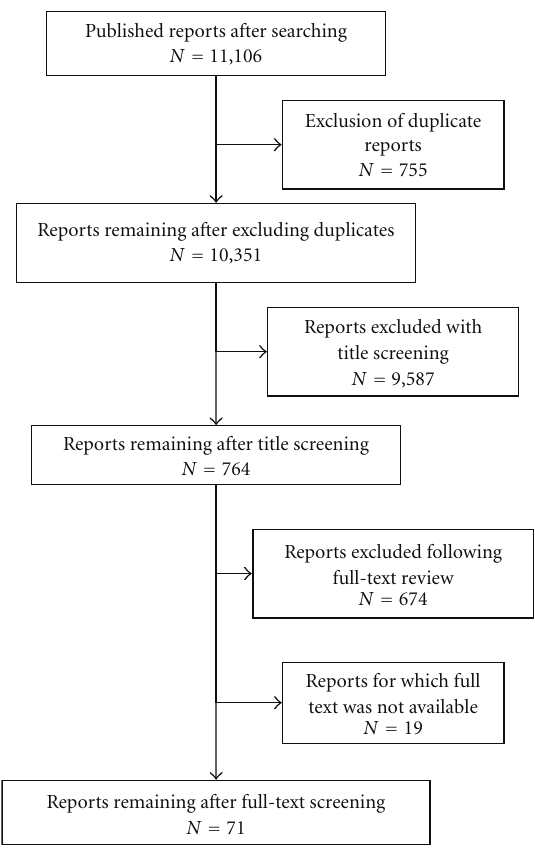
Figure 1: Study flow diagram showing review of reports.